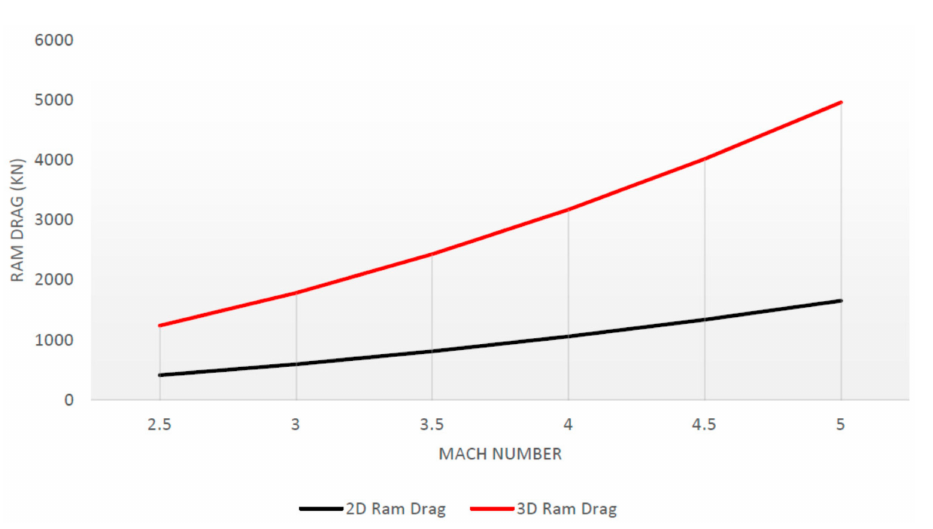
Figure 17. Pressure recovery